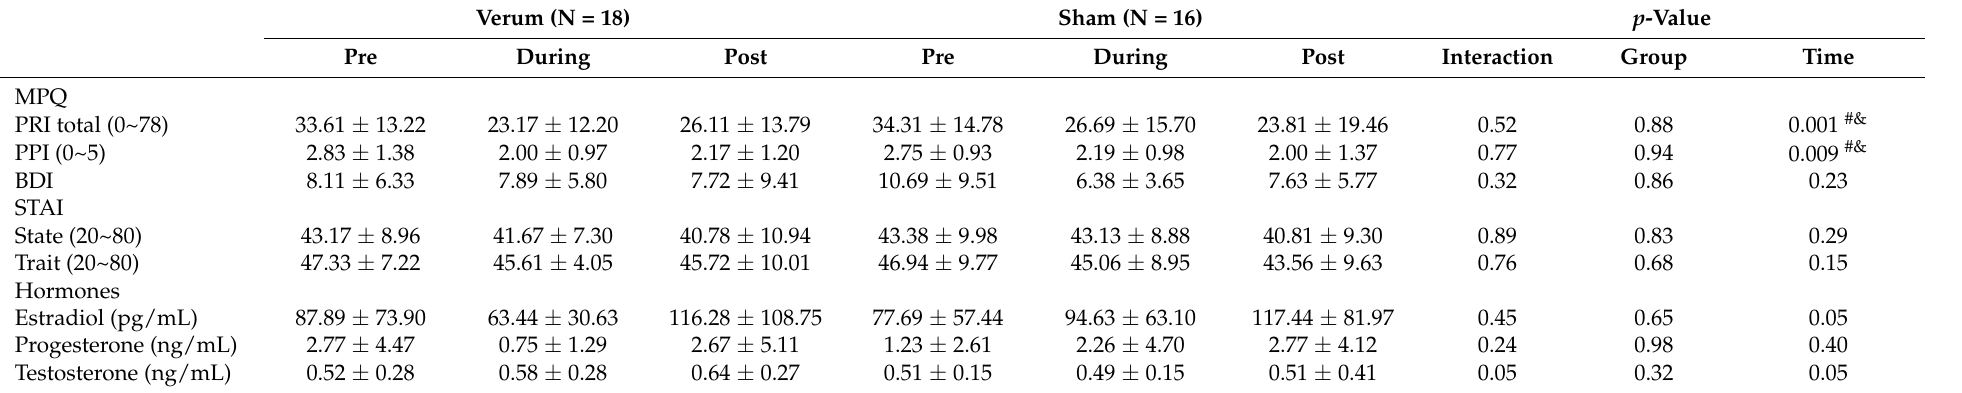
Table 2. Menstrual pain experience, psychological assessment, and gonadal hormone level across acupuncture intervention. Verum (N = 18) Sham (N = 16) p -Value